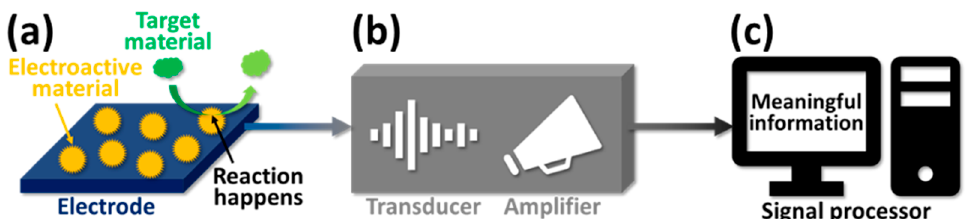
Figure 2. An illustration of the glucose concentration detection system via the electrochemical technique and the following signal processes. ( a ) Firstly, electro-oxidation of glucose target on the surface of the electroactive materials, which is deposited on the substrate. ( b ) Secondly, the current response is processed by the transducer and amplifier. ( c ) Finally, the current response is information-processed to extract characteristic parameters by the signal processor.